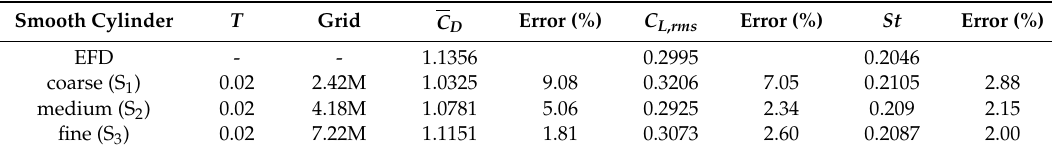
Table 1. Grid independence verification on smooth cylinder.